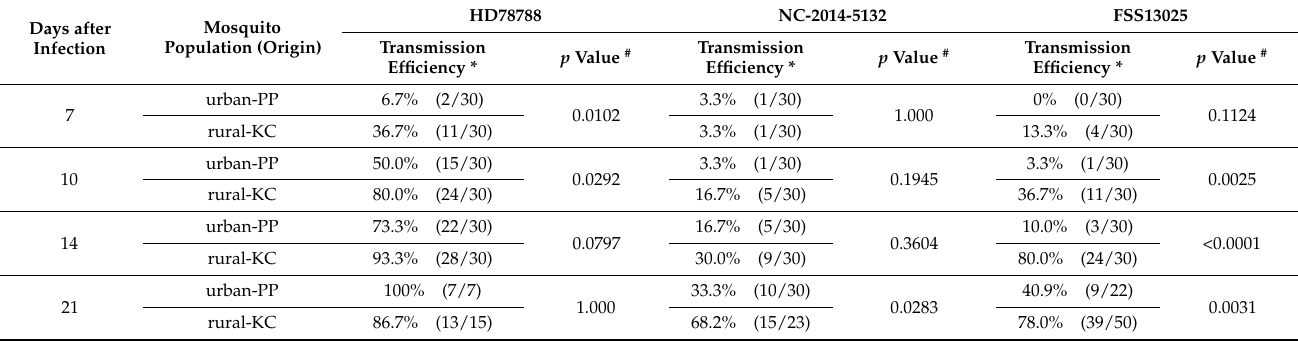
Table 1. ZIKV transmission efficiency of two Cambodian Ae. aegypti